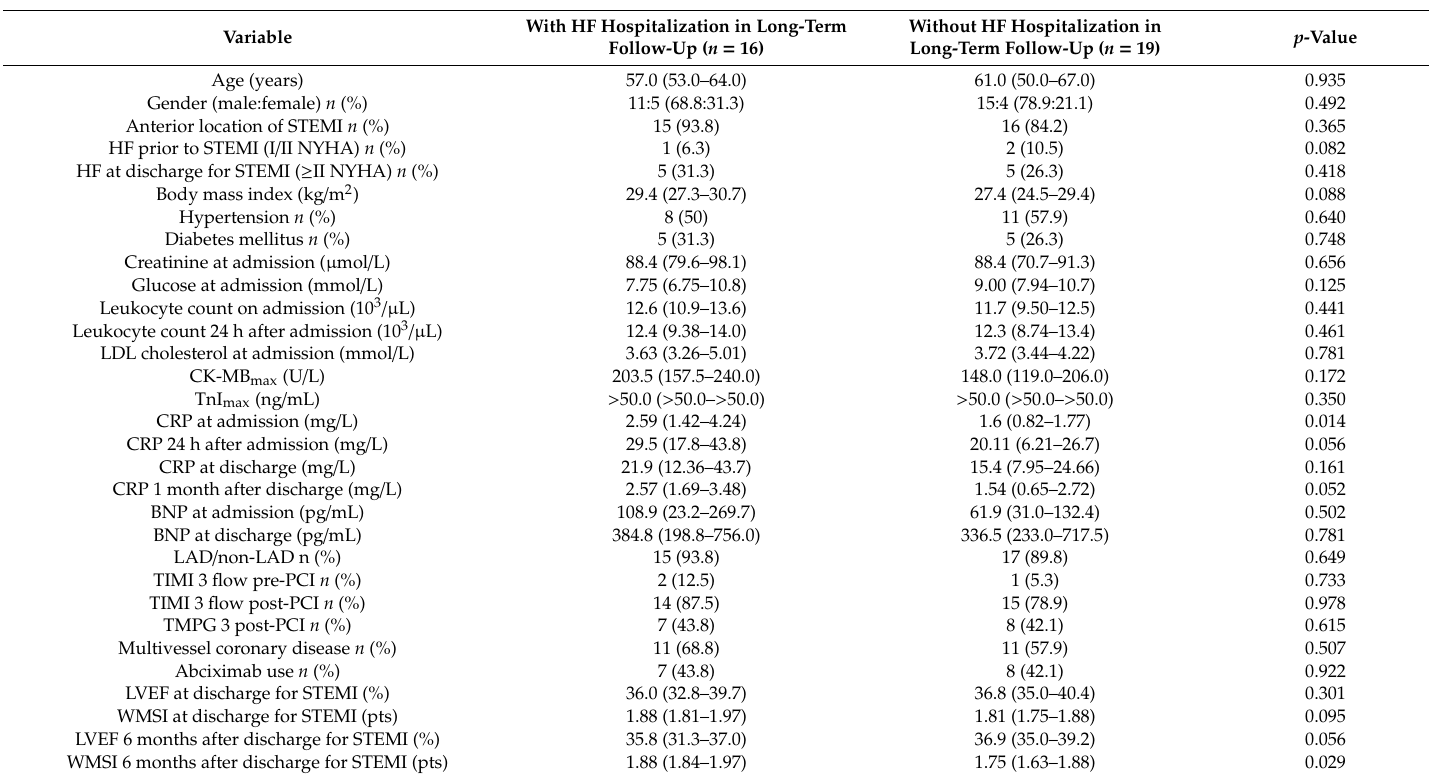
Table 3. Baseline characteristics of two patient groups with left ventricular systolic dysfunction 6 months after discharge post ST-segment elevation myocardial infarction based on the need for hospitalization for heart failure in long-term follow-up. With HF Hospitalization in Long-Term Without HF Hospitalization in p Variable Follow-Up ( n = 16) Long-Term Follow-Up ( n = 19)